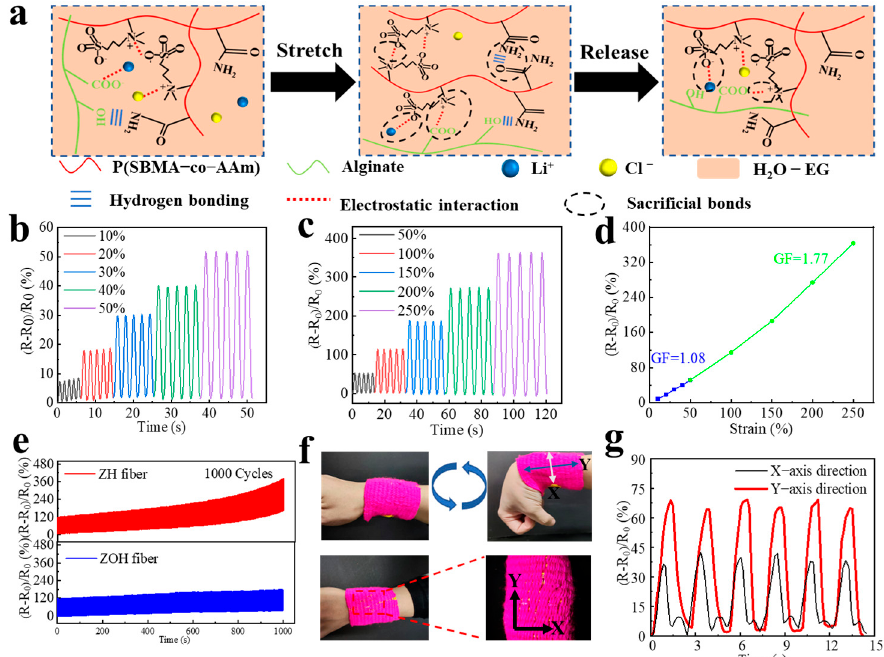
Figure 3. ( a ) Schematic of the evolution of a hybrid crosslinking network in the fiber during stretching. ( b ) Relative resistance changes in the strain sensor made from the ZOH fiber under small strains (10%, 20%, 30%, 40%, and 50%) cycles. ( c ) Relative resistance changes in the ZOH fiber-based sensor under large strains (50%, 100%, 150%, 200%, and 250%) cycles. ( d ) Relative resistance changes in ZOH fiber-based sensor as a function of strain. ( e ) Relative resistance changes in the ZOH fiber and the ZH fiber during cyclic stretching with a strain of 100% for 1000 cycles. ( f ) Photographs of the ZOH fiber woven into a fabric to create an anisotropic strain sensor and a wrist performing a bending motion. ( g ) The relative resistance changes in fibers in the X and Y directions with the bending and relaxing of the wrist.